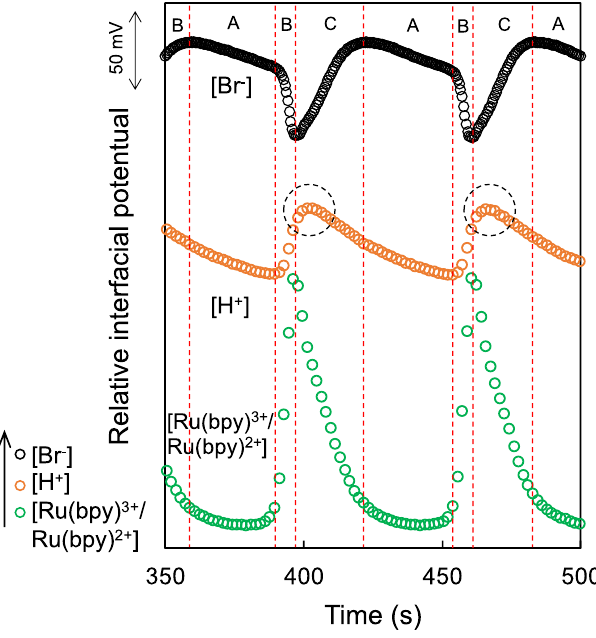
Figure 3. Self-oscillation behaviors of [H + ], [Ru(bpy) 3+ /Ru(bpy) 2+ ], and [Br - ] based on relative interfacial potential. The durations of Processes A, B, and C based on the FKN mechanism (Table S2) are delineated by the dotted lines (red). The dotted circle (black) shows the position of the peak [H +